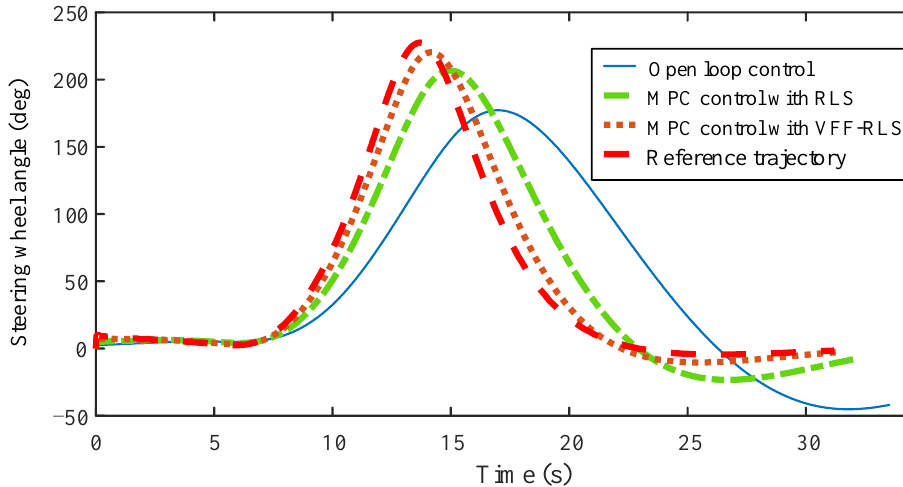
Figure 10. Vehicle trajectory under Scenario A.